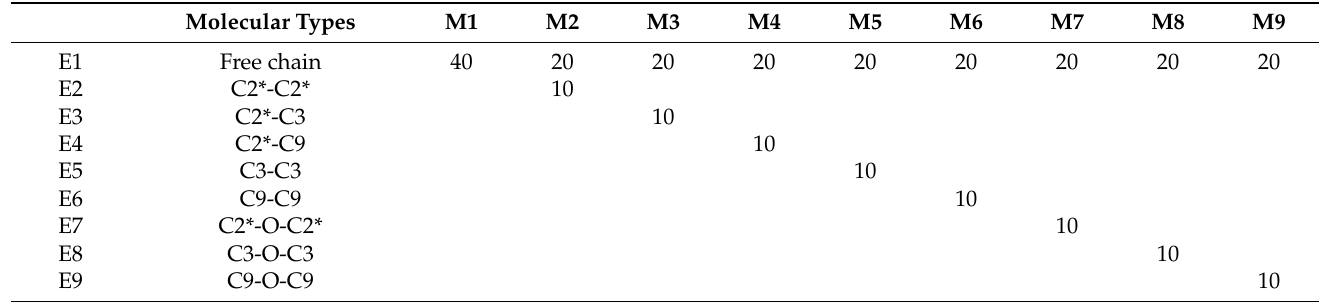
Table 1. Composition and naming of the cross-linked MD model of